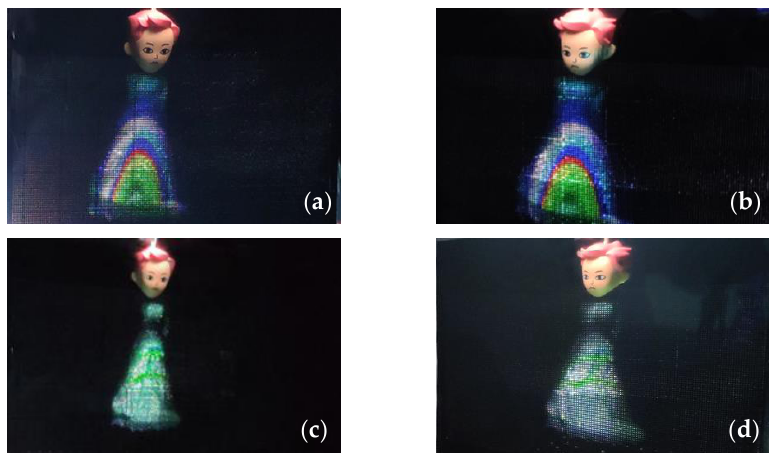
Figure 6. AR fitting application by using the proposed prototype. ( a ) Right view; ( b ) left view; ( c ) right view , and ( d ) left view.